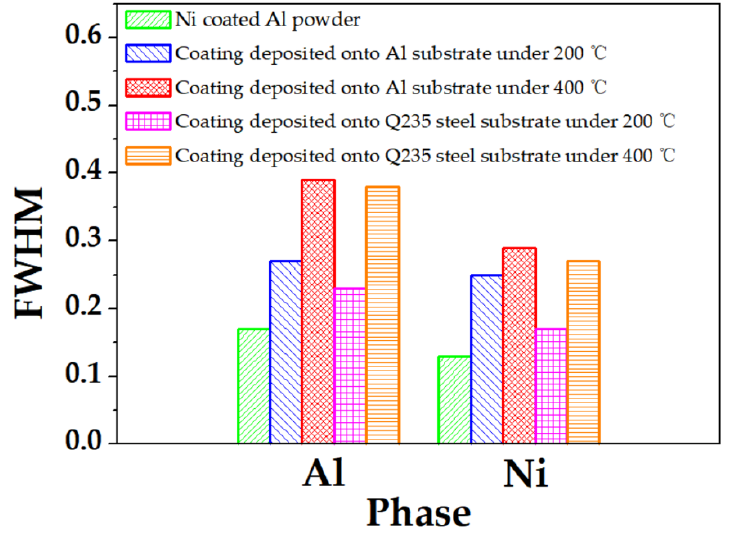
Figure 12. Full widths at half maximum (FWHMs) of Ni and Al in Ni-coated Al powders and coatings.